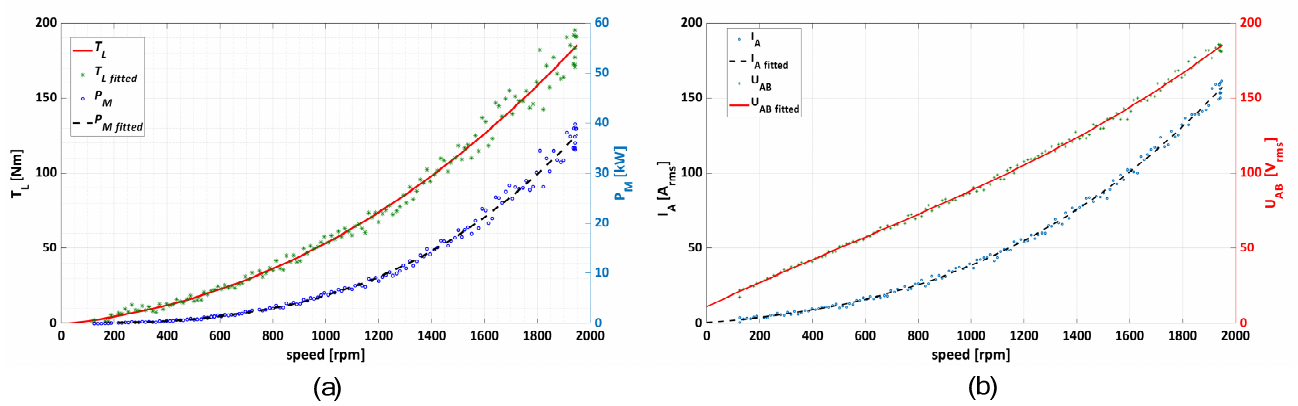
Figure 3. Torque-speed and power speed characteristics of the propeller in stationary conditions ( a ), and motor voltage and current characteristics vs. speed ( b ).